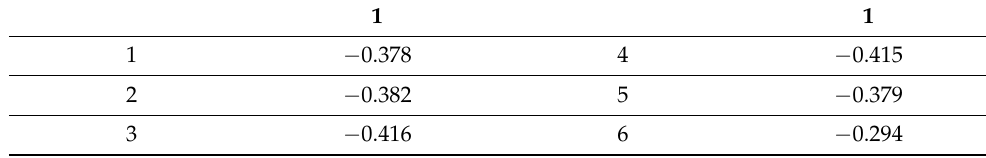
Table 4. Improved mean data.